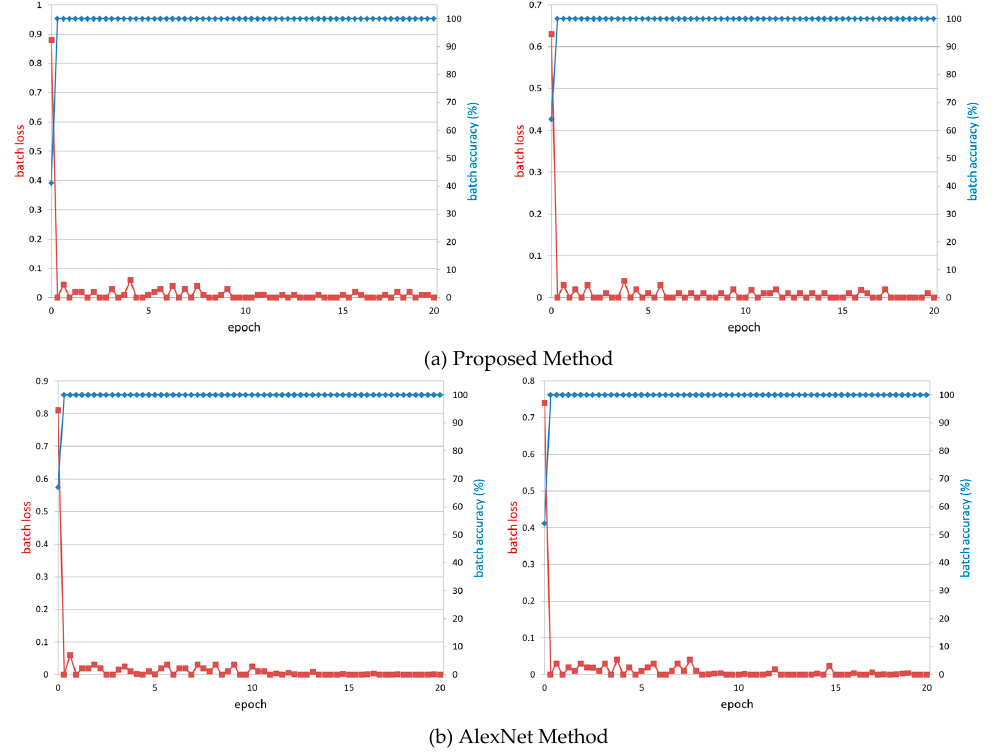
Figure 12. Accuracy and loss curves of training according to the number of epoch ( a ) Proposed method ( b ) AlexNet method.